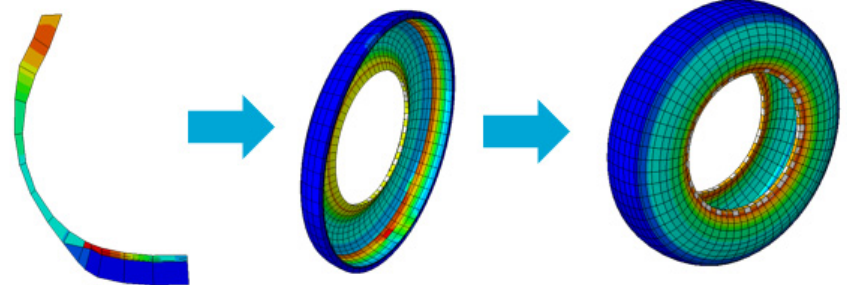
Figure 5. The FEM model of the 305/R70 22.5 tire .